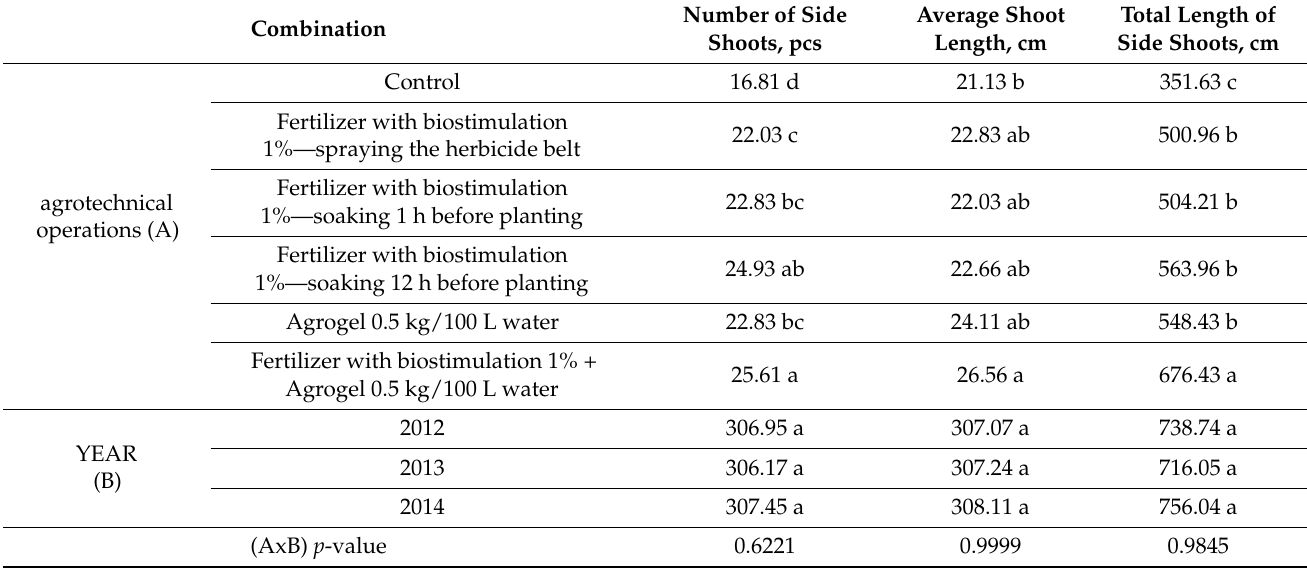
Table 2. Impact of agrotechnical treatments on the number and average length of shoots and the sum of the length of the side shoots of young apple trees of the ‘Gala Must’